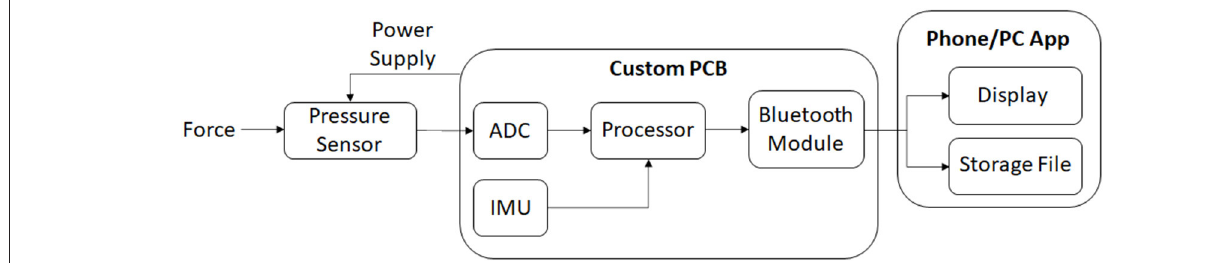
FIGURE 3 | Flow diagram indicating the data collection process.